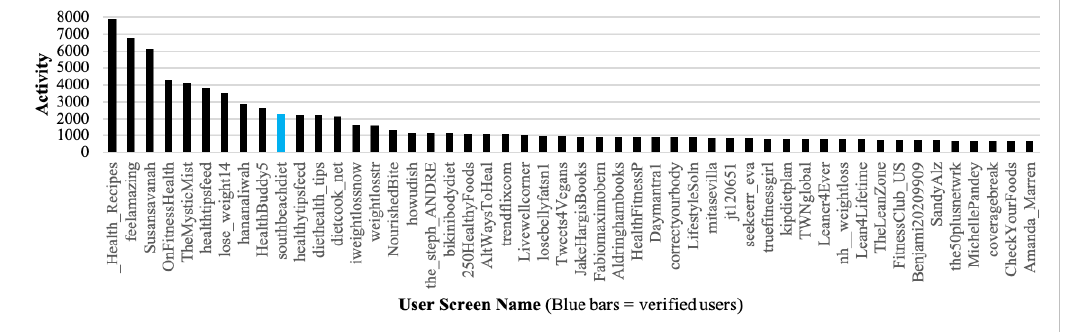
Figure 2. Most Active